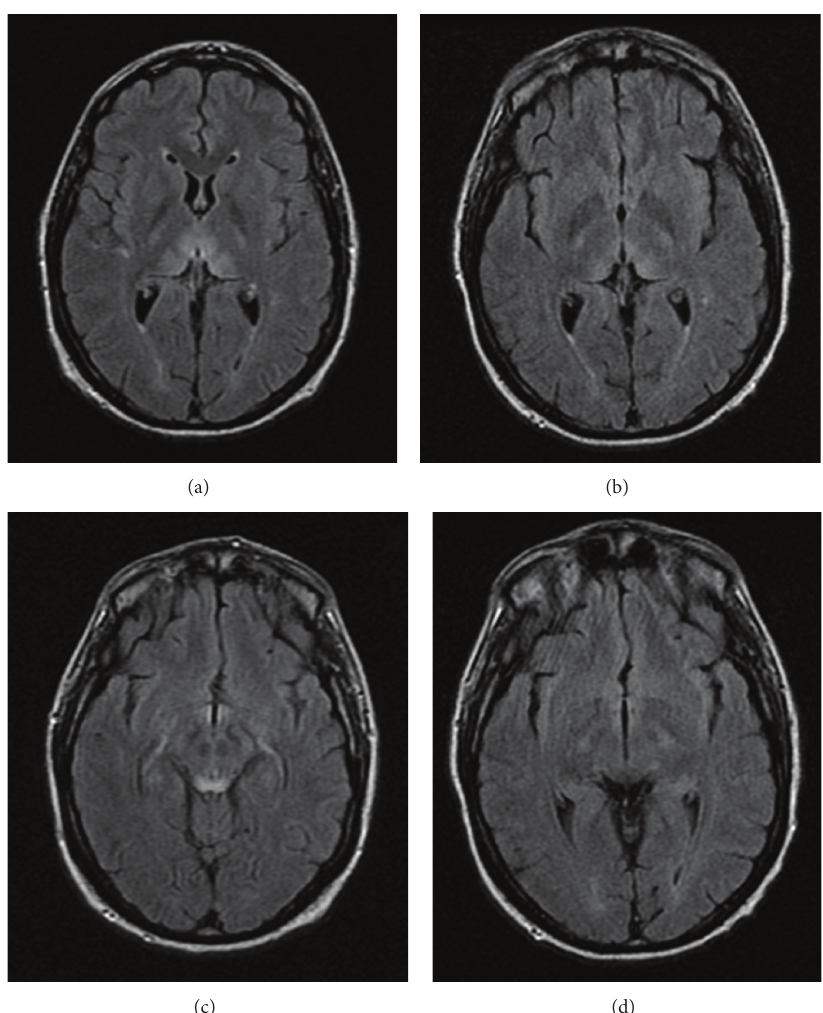
Figure 2: Corresponding FLAIR MRIs one day ((a), (c)) and seven days ((b), (d)) after admission. Signal abnormalities in bilateral thalami (a) andintervalimprovement(b).Signalabnormalitiesinvolvingthehypothalamus(c),periaqueductalgraymatter(c),andintervalimprovement